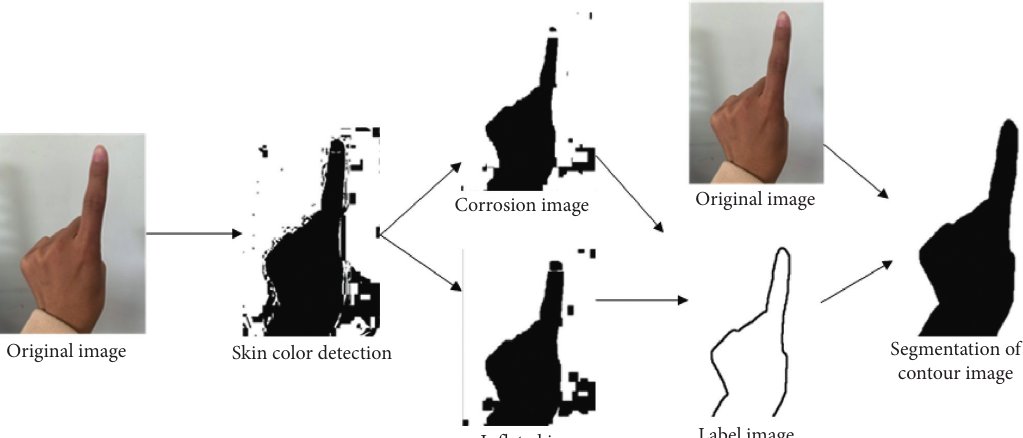
Figure 3: Data image segmentation process.